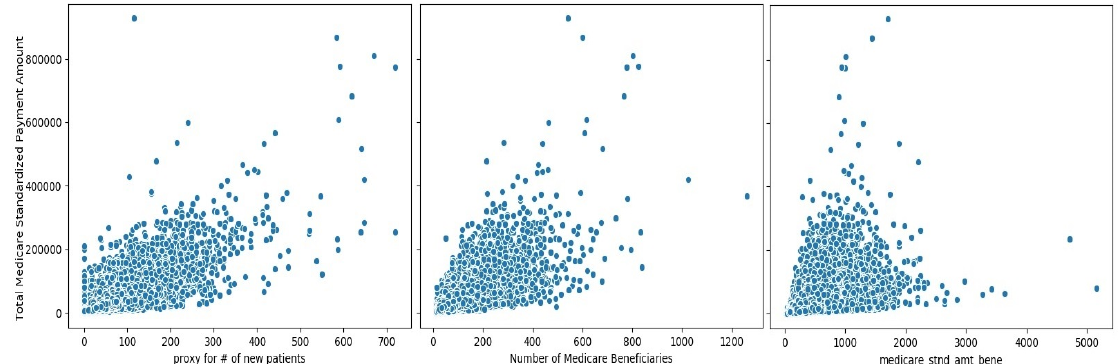
Figure 2. Scatter plots for the top three selected variables against predicted feature plots.